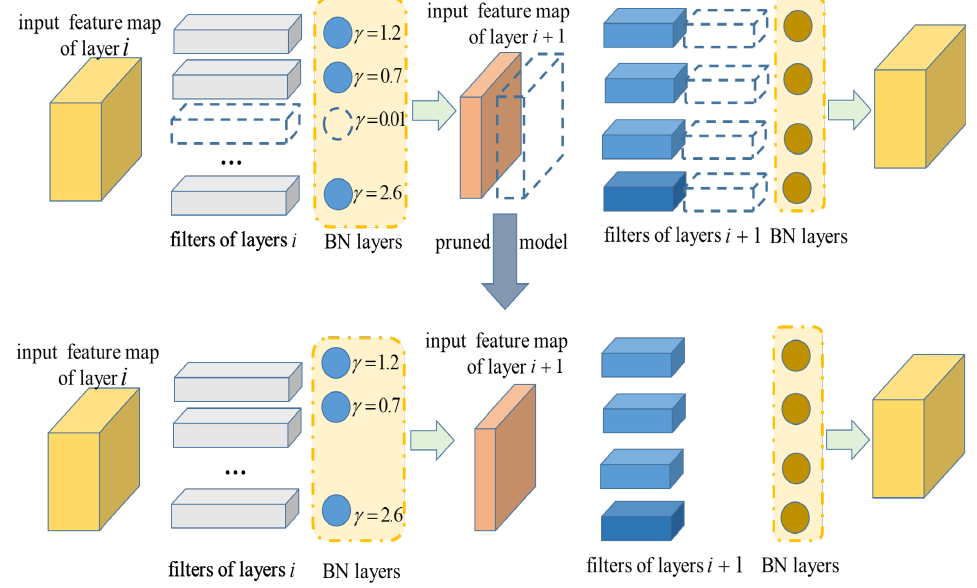
Figure 2. Network pruning process. The dotted line in the upper part of the image represents the filter and feature map that the network needs to be pruned, and the bottom part represents the pruned network. When channels with a γ value less than the fixed threshold are eliminated in the current convolution layer, the filters of the next layer in the channel dimension also need to be deleted